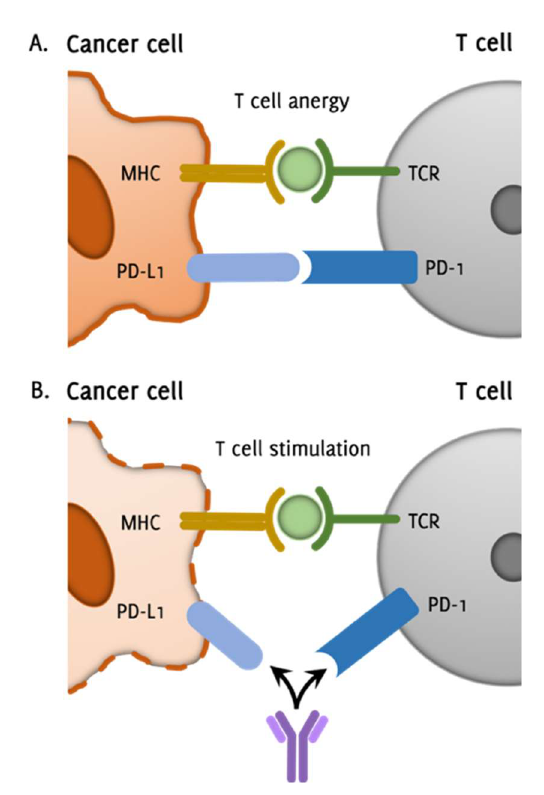
Legend: Simplified illustration demonstrating the mechanism of immune checkpoint inhibition in cancer immunotherapy. Figure 1.A . shows the T cell programmed